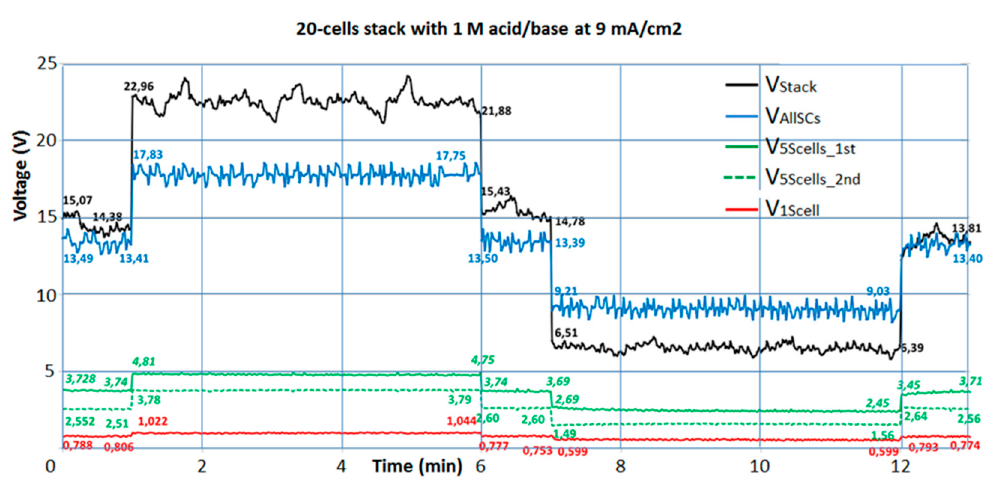
Figure 6. Charge and discharge behavior of a 20-cell stack with 1 M acid/base at 25 °C and 9 mA/cm 2 current density. The black line is the stack voltage measured across the electrodes; the blue line is the stack voltage across the 20-cell units. The voltages measured across the first repeating cell unit next to the electrode (red), the first 5-cell unit (green, solid) and the second 5-cell unit (green, dotted) are also shown.